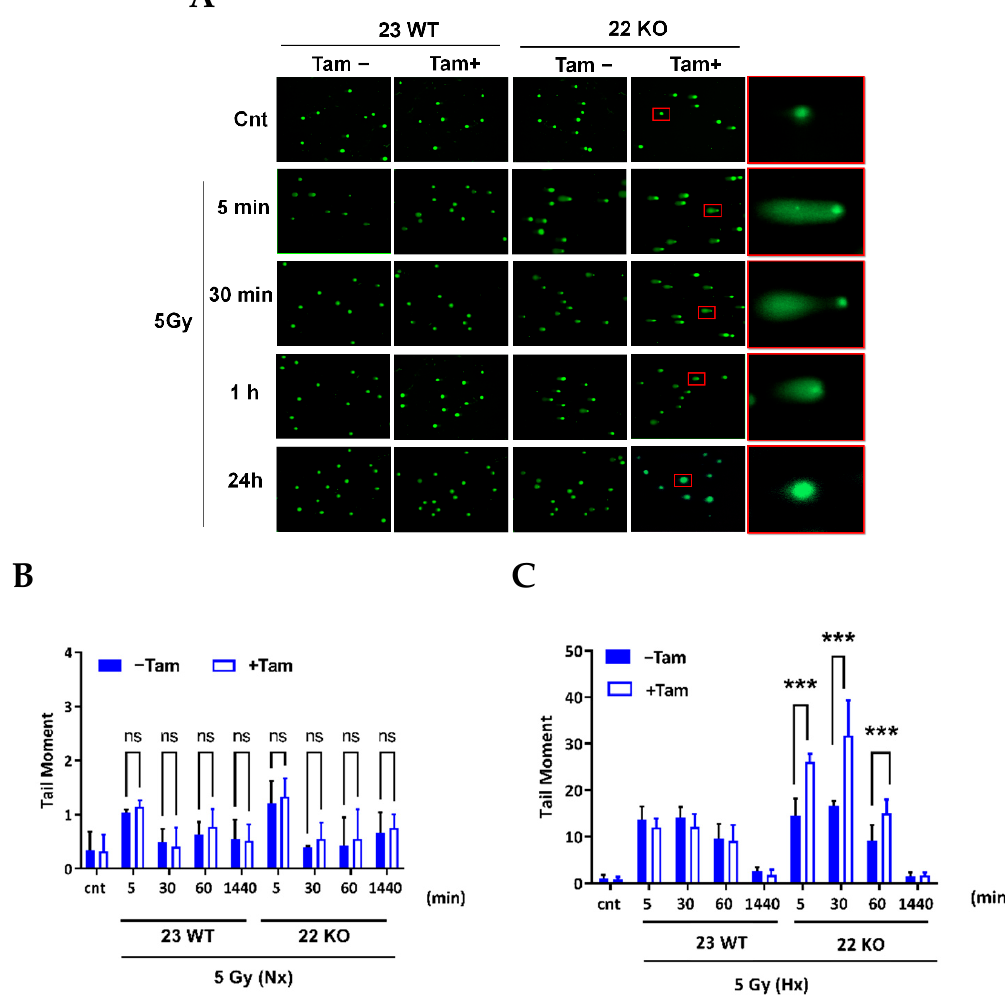
Figure 10. Effect of HIF-1 α knockout on DSB repair mechanisms as assessed by a neutral comet assay. After IR, the cells were embedded in 1% agarose gels, lysed, and subjected to electrophoresis at 25 V, 300 mA for 25 min. ( A ) Representative fluorescence microscopy images are shown, red squares show KO cells in hypoxia chosen for higher magnification. The tail moment (percentage of DNA in the tail) was determined in 50 cells per slide with the open-source analysis program OpenComet v1.3.1 in normoxia (NX). ( B ) and hypoxia (HX) ( C ). Bars show mean ± SD, the groups were compared using two-way ANOVA, *** p < 0.001. ns p > 0.05.